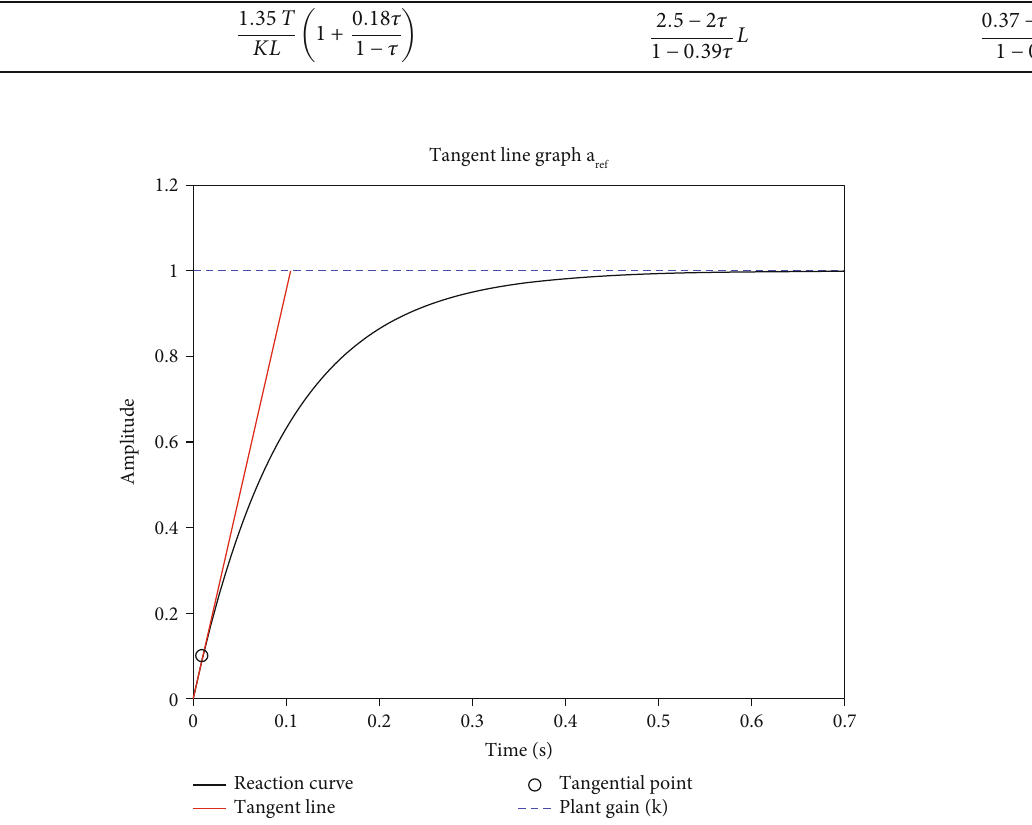
tangent line in open-loop PI (1). ref